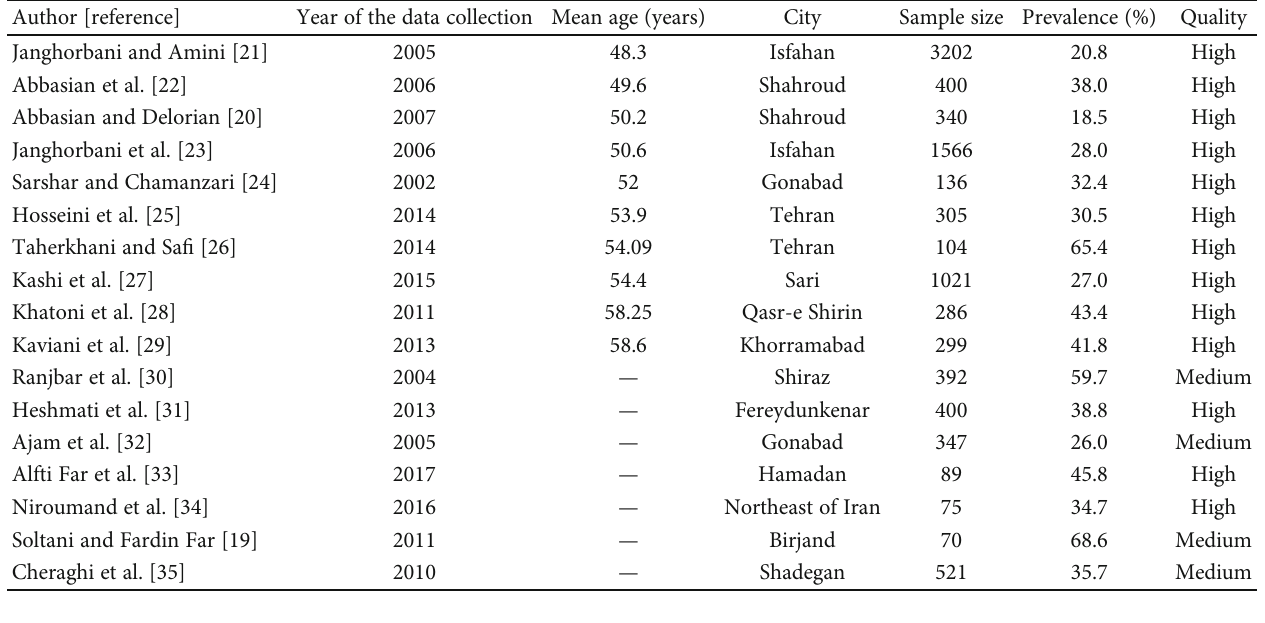
Table 1: Characteristics of included studies in the prevalence of cardiovascular disease in patients with type 2 diabetes.